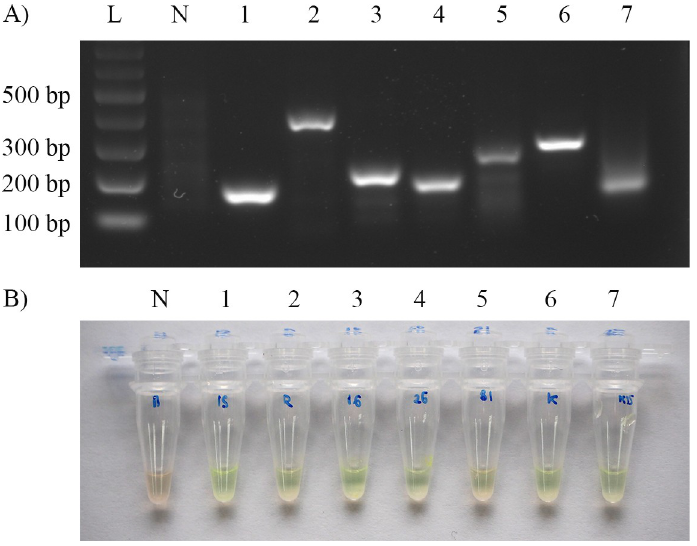
Fig 1. Results of the AS-RPA/SYBR assay validated with the M . tuberculosis wild-type strain. (A) RPA amplicons were detected via agarose gel electrophoresis. The product sizes from each pair of primers were 173 bp, 363 bp, 213 bp, 182 bp, 250 bp, 276 bp and 152 bp for the IS1081, rpoB , rpoB 516, rpoB 526, rpoB 531, katG and katG 315 primers, respectively. Lane L: 100-bp DNA ladder, Lane N: no template control; Lane 1: IS1081 primer; Lane 2: rpoB primer; Lane 3: rpoB 516 primer; Lane 4: rpoB 526 primer; Lane 5: rpoB 531 primer; Lane 6: katG primer; Lane 7: katG 315 primer. (B) The naked-eye endpoint detection method was performed by adding SYBR Green I directly to the reaction tubes. Tube N is a no-template control; tubes 1 to 7 contained the IS1081, rpoB , rpoB 516, rpoB 526, rpoB 531, katG and katG 315 primers, respectively, showing a green colour, which implied a positive amplification result and no mutation at those allele-specific sites.